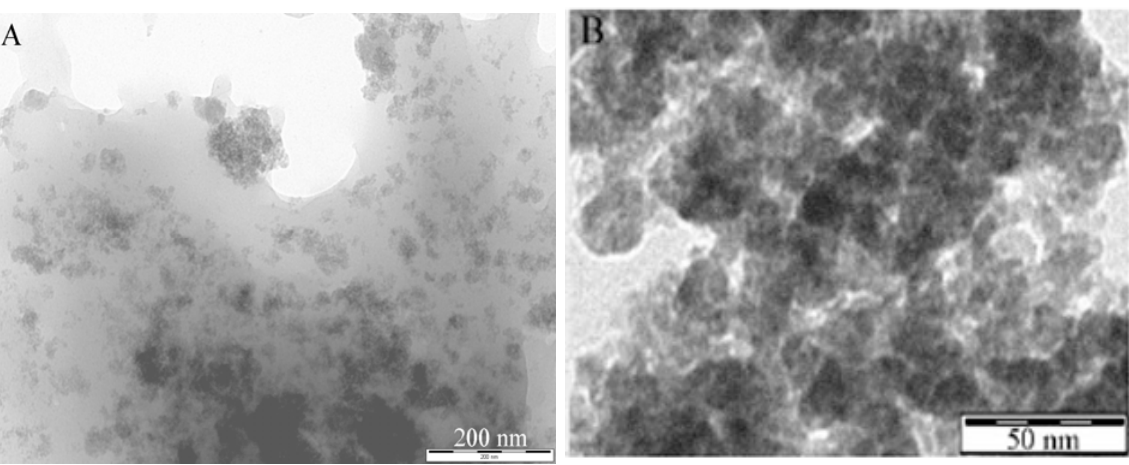
Figure 3. Mesoporous polysaccharide supported CdS quantum dots. Adapted from reference